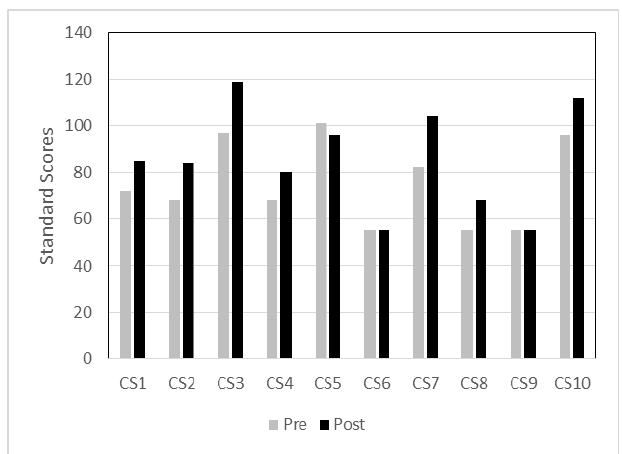
Figure 4. Individual standard scores of pre- and post-tests in the in-person